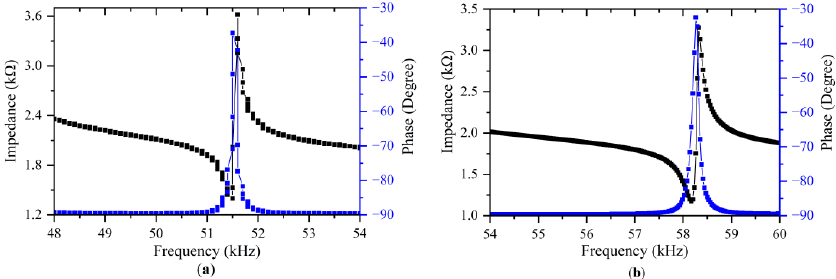
Figure 8. Admittance characteristics of the standing wave vibrator: ( a ) Longitudinal vibration; ( b ) Bending vibration. Table 4. Comparison of the resonant frequencies of the two modes obtained by simulation and experiment. Standing Wave Vibrator Traveling Wave